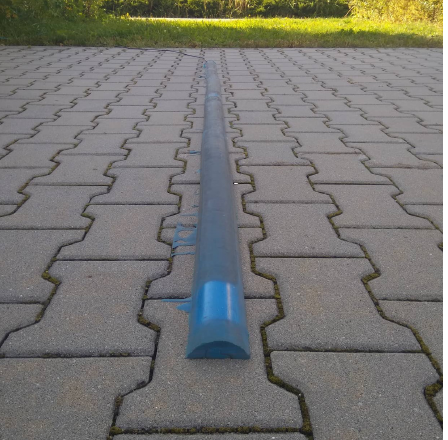
Figure 3. Portable measuring FBG